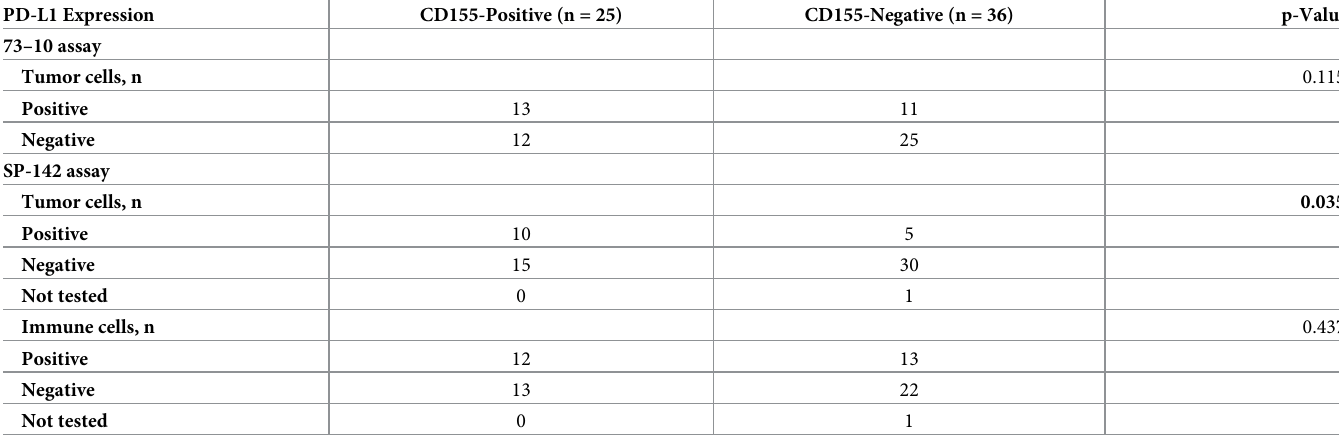
Table 3. Correlation between CD155 and PD-L1 expression.